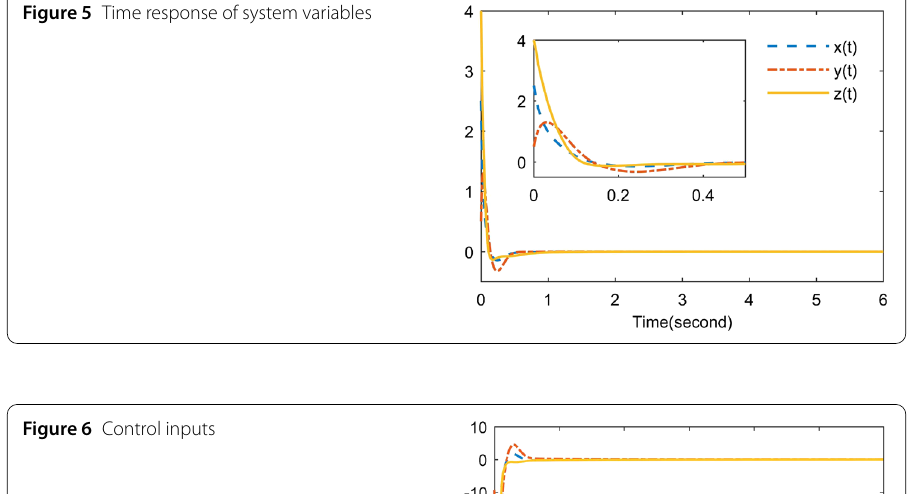
Figure 5 Time response of system